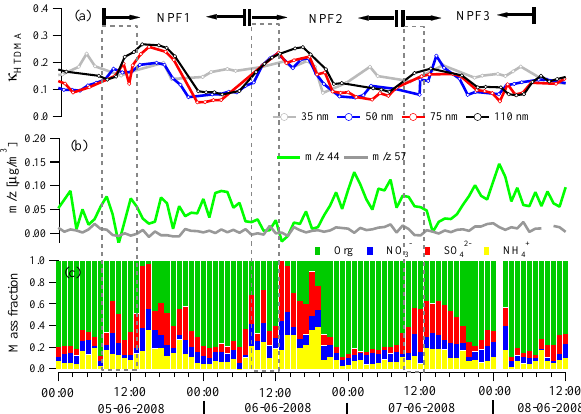
Figure 3. Size-resolved particle hygroscopicity (a) ; m/z 44 and 57 mass concentrations in 30–100nm particles (b) ; and mass frac- tion of organic, sulfate, nitrate, and ammonium in 30–100nm parti- cles (c) . The grey dashed lines indicated the time period of particle